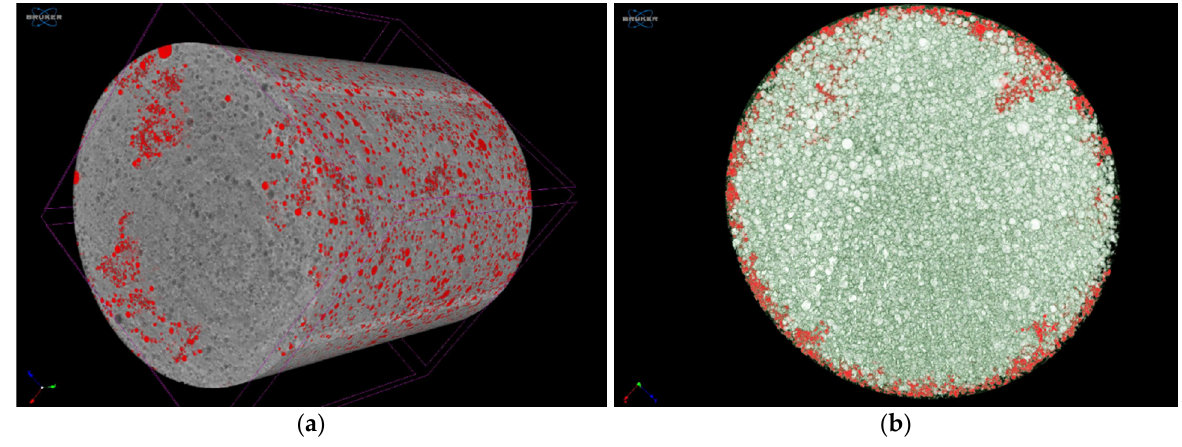
Figure 7. Reconstructed model of the foamed melt presenting the opened cavities in a full capsule ( a ) and cross section ( b ).